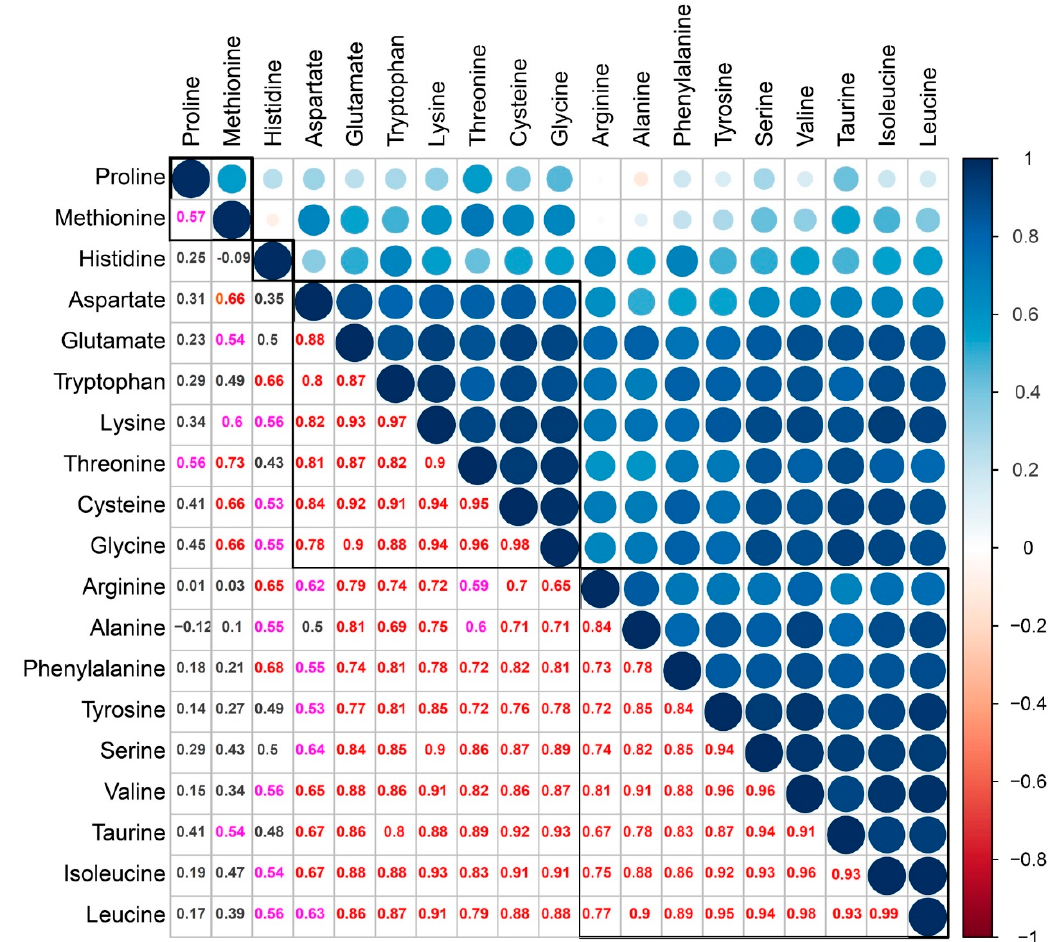
Figure 4. Correlation analyses between each amino acid and clustering with hclust. The bubble size and numbers refer to Pearson coefficients, the blue bubble represent positive correlation and red means negative. The purple numbers represent the significant correlation with p < 0.05, and the red numbers represent the significant correlation with p < 0.01.